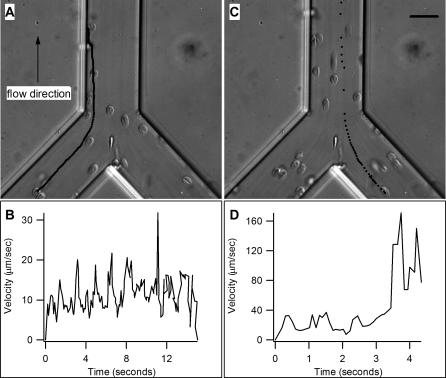
Rolling iRBCs Merging into a Single Channel from a BifurcationThe branching channel was functionalized with ICAM-1.(A, C) Dots represent the spatial position of two differently behaving, rolling iRBCs every 0.1 s at 3 kPa applied pressure.(B) Instantaneous velocity of a rolling cell pictured in (A). The iRBC approaches the fork in the channel after approximately 8 s, but shows no change in rolling velocity.(D) Instantaneous velocity of a rolling iRBC pictured in (C). The iRBC is rolling with a higher velocity than the one pictured in (A) and approaches the fork after approximately 3 s. The iRBC continues rolling in the straight portion of the channel, albeit at a much higher velocity.Scale bar = 25 μm. See also Video S3.